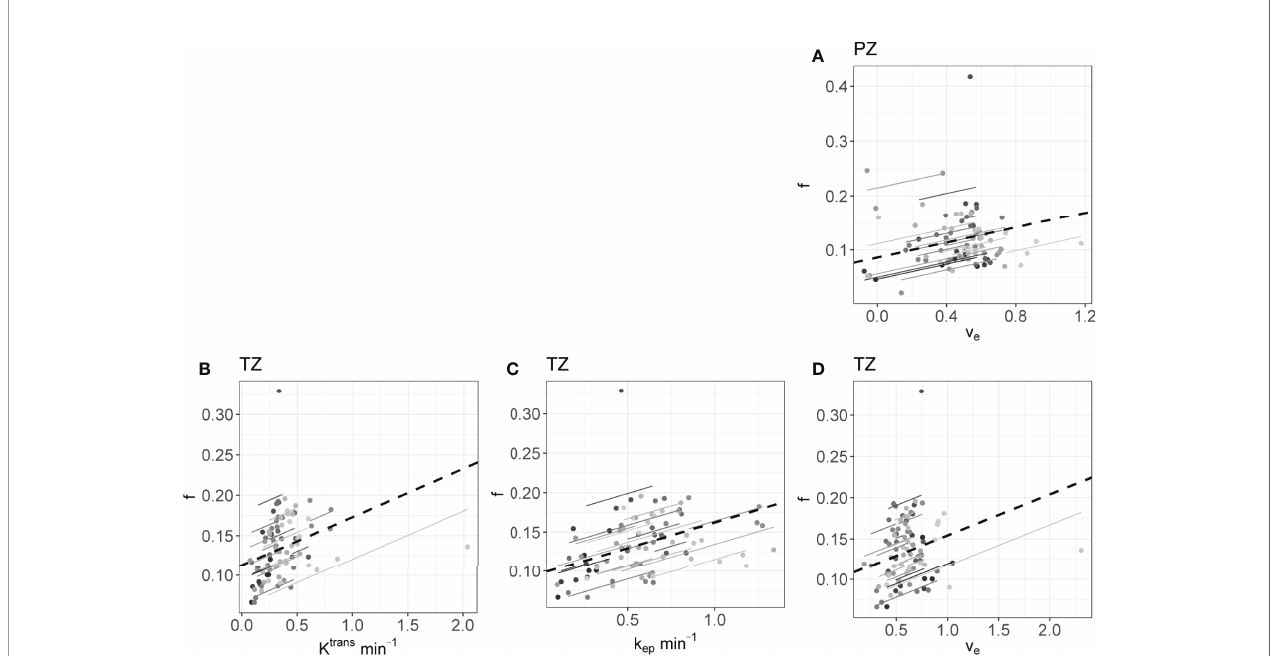
FIGURE 4 | The signi fi cant repeated measures correlations of f with the DCE parameters are shown. (A) is the correlation between f and v e in the PZ, (B – D) are values from the TZ. Each line shows the fi t for a single patient and the dashed black line shows the overall common slope.